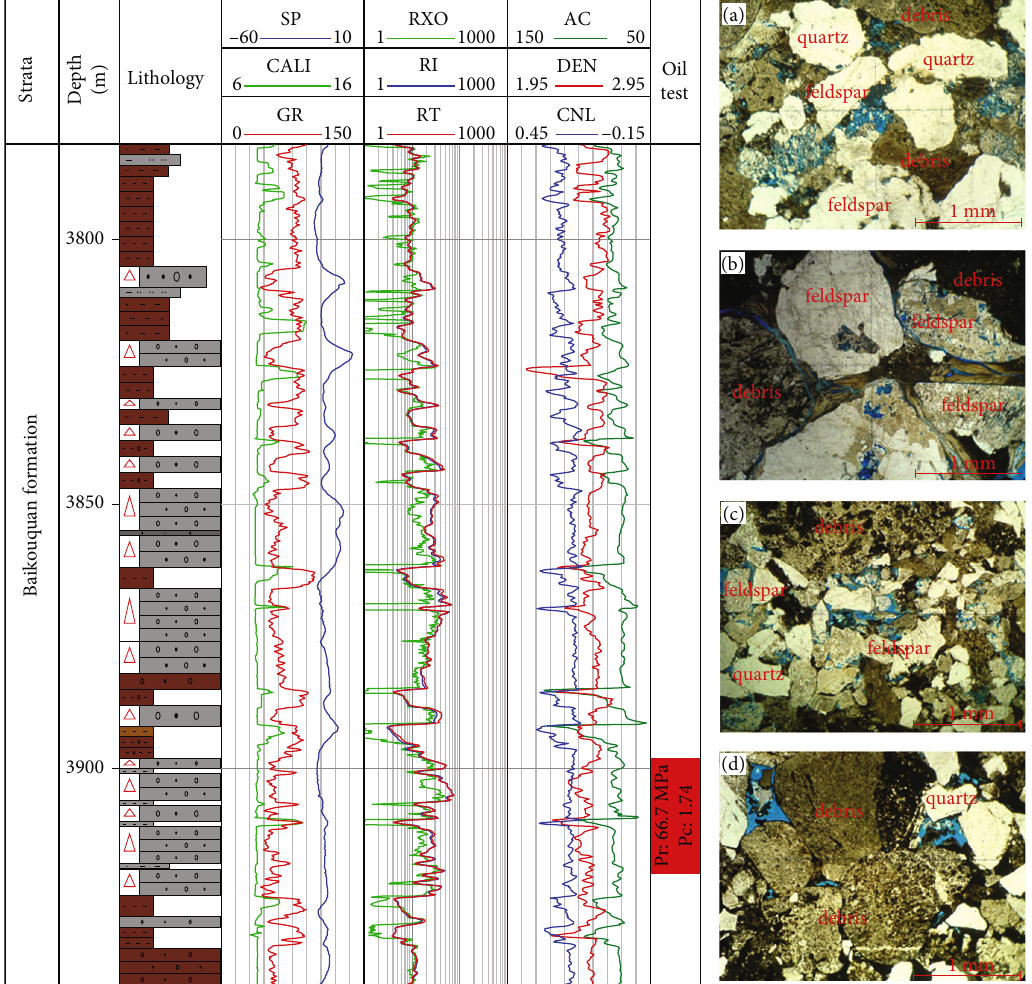
Figure 7: Synthesis columns of Well M18 and thin sections of the Baikouquan Formation: (a) conglomerate, 3904.9m; (b) conglomerate, 3915.8m; (c) coarse sandstone, 3917.3m; and (d) conglomerate,